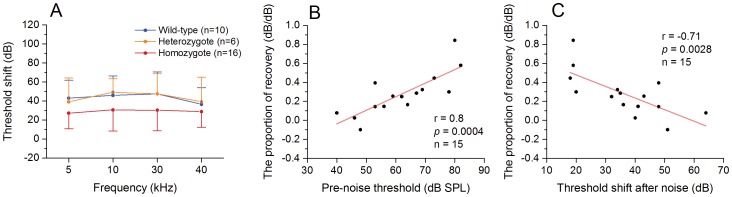
The recovery of ABR thresholds is associated with the level of pre-noise ABR thresholds in the Prestin-CreERT2 homozygous mice.
A Comparison of ABR threshold shifts among the homozygous, heterozygous and WT mice examined at 7 d post-noise exposure. The homozygotes displays less threshold shifts as compared with the heterozygous and WT mice (two-way ANOVA, F2,116 = 16.77, P<0.001). B Correction of the recovery proportion of ABR thresholds and the pre-noise ABR thresholds. The proportion of ABR recovery is increased with the increase in the level of pre-noise ABR thresholds (Pearson's correction analysis, r = 0.8; p = 0.0004). The results suggest that the functional status of OHCs before exposure to the noise affects the functional recovery of the cochleae after exposure to the noise. C Correction of the recovery of ABR thresholds and the acute threshold shifts examined at 2 h post the acoustic overstimulation. Notice that with the increase in the magnitude of threshold shifts, the proportion of ABR recovery is decreased (Pearson's correction analysis, r = −0.71; p = 0.0028).